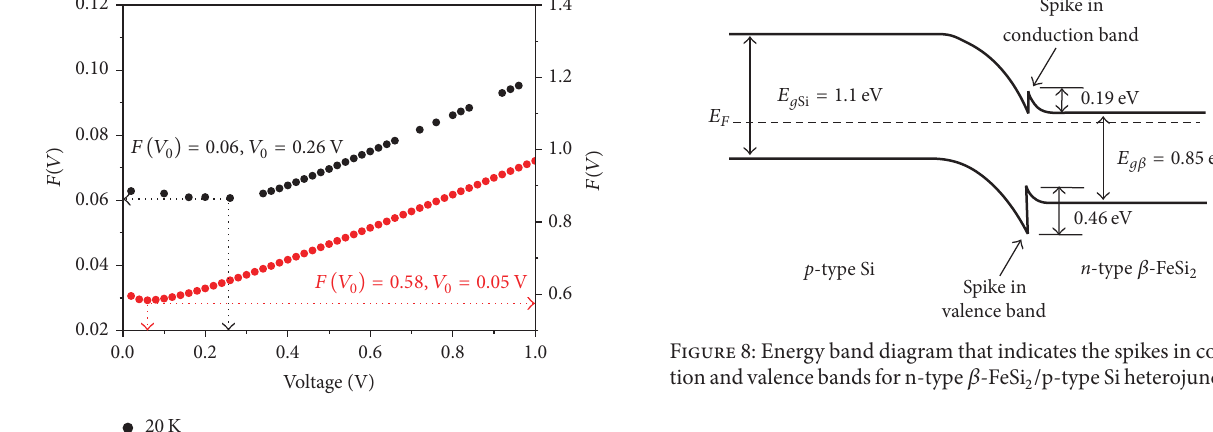
The plots of 𝐹(𝑉) - 𝑉 at temperatures of 300 K (red line) and 20 K (black line) are displayed in Figure 7. From the plot at 300 K, the values for 𝐹(𝑉 0 ) and 𝑉 0 were 0.58 and 0.05 V, respectively. The values for 𝐹(𝑉 0 ) and 𝑉 0 at 20 K changed to 0.06 and 0.26 V, respectively. Based on the computation using (8), the 𝜙 𝑏 values were 0.58 eV at 300 K and 0.07 eV at 20 K. In addition, 𝑅 𝑠 value computed by (9) was 10.93 Ω at 300 K and enhanced dramatically to 0.15 M Ω at 20 K. The results from computation using Norde’s method were in agreement with those computed by the TE theory and Cheung’s method.